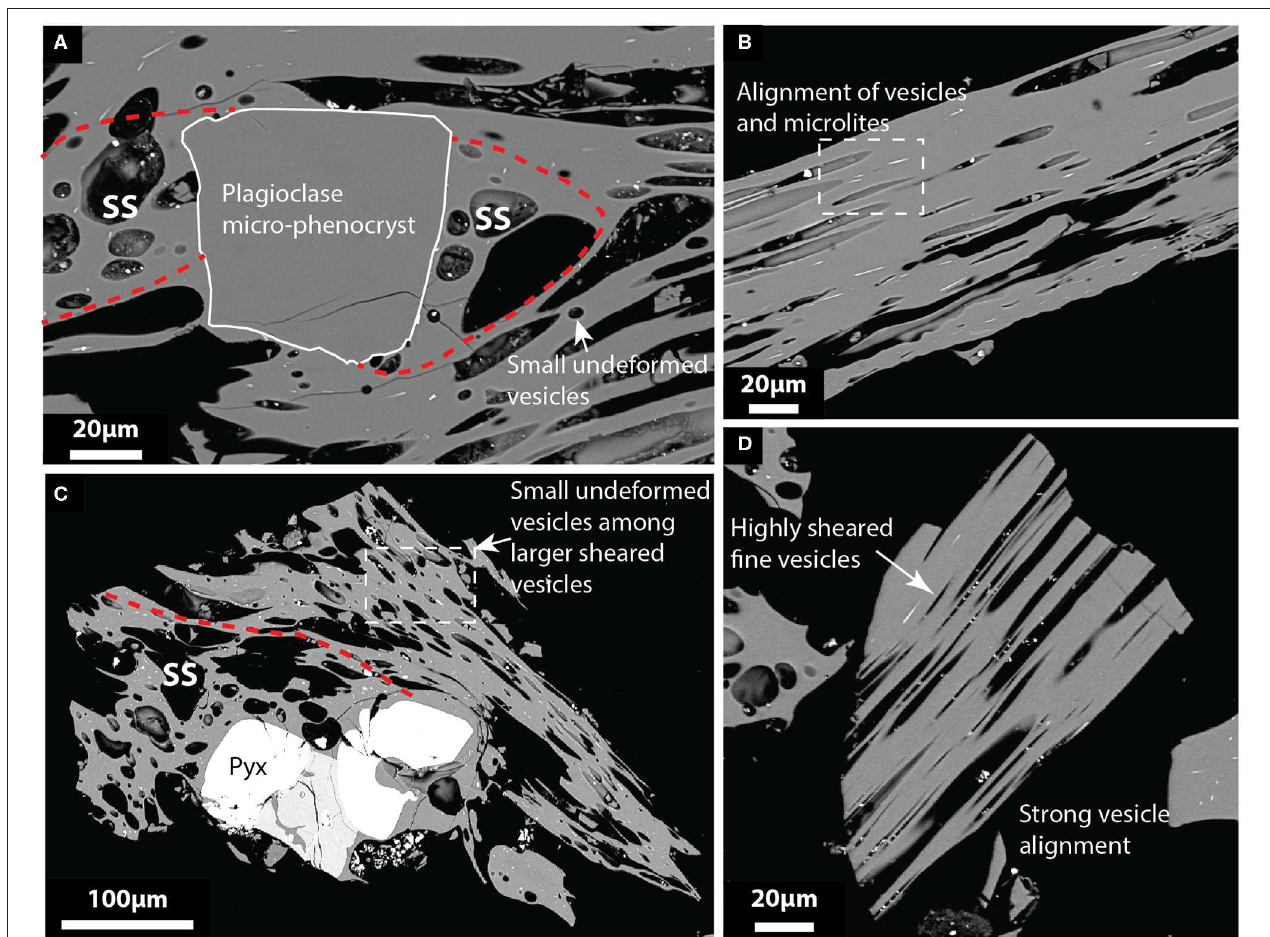
FIGURE 6 | Microtextural characteristics of Elongate tube-vesicle grains. SEM images taken approximately along the vesicle-elongation axis. (A) Asymmetrical strain shadow defined by undeformed vesicles around a euhedral plagioclase micro-phenocryst. Outside the area of the strain shadow small undeformed vesicles are also scattered within areas of highly sheared vesicles. (B) Highly elongate needle-like vesicles are aligned with microlites within a particle that appears to have a smooth unbroken surface. (C) Half a strain shadow can be observed around a micro-phenocryst cluster. Small, undeformed vesicles are present in the sheared domain. (D) shows strong vesicle deformation over a range of vesicle